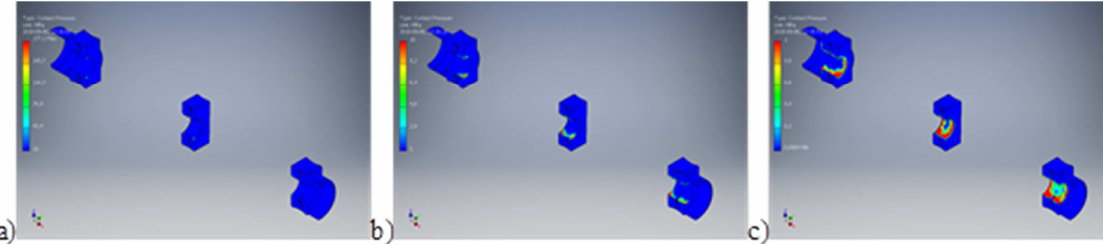
Fig. 16. The distribution of contact pressure on surfaces of the bearing covers for the rotational speed of the camshaft equal to 750 rpm